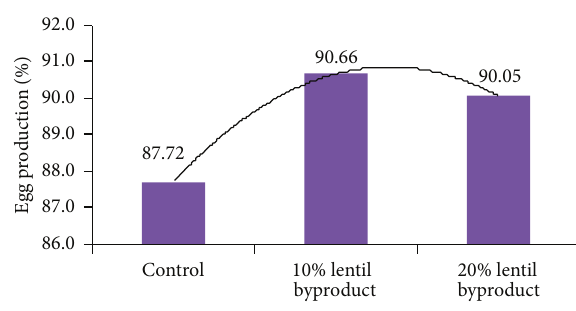
Figure 2: Effect of lentil byproduct on egg production.